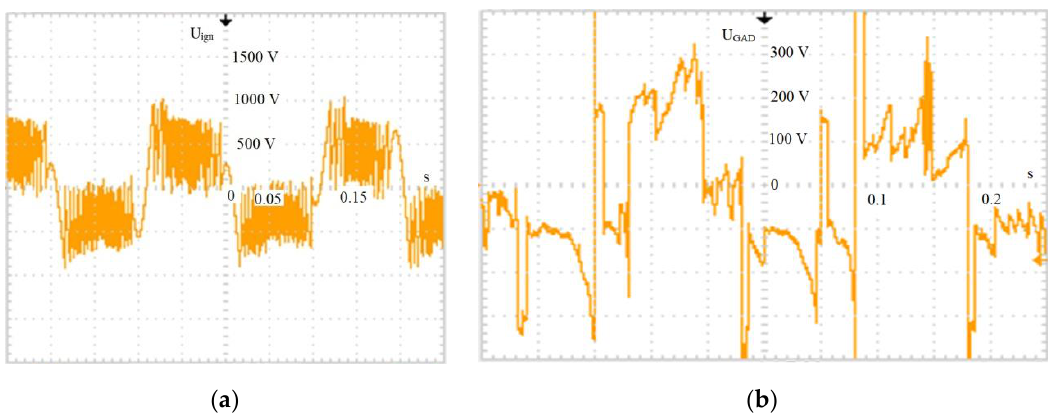
Figure 7. (a) Ignition voltage U ign waveform (distance between ignition electrodes 5 mm) when supplied from external windings connected in series of the five-column transformer ( b ) voltage U GAD between electrodes of GAD reactor in argon, at a the primary voltage of 90V, [44].